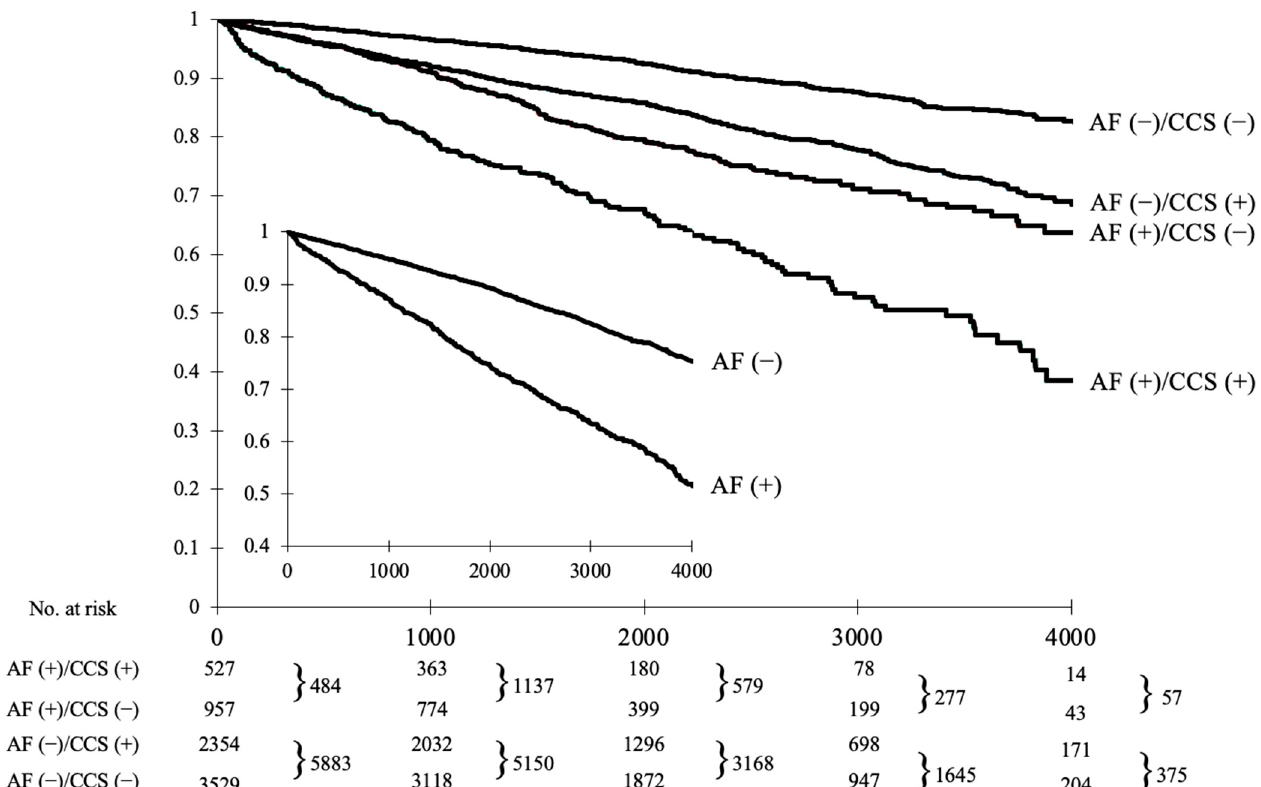
Figure 2. Kaplan–Meier survival analysis of all-cause mortality in relation of the diagnosis of atrial fibrillation and obstructive chronic coronary syndrome (large graph). The inner graph represents the comparison between patients with and without atrial fibrillation independently of the diagnosis of obstructive chronic coronary syndrome. All differences between curves are statistically significant (adjusted p values < 0.01 for all tests). AF, atrial fibrillation; CCS, chronic coronary syndrome. Table 3. Causes of deaths in the study participants.